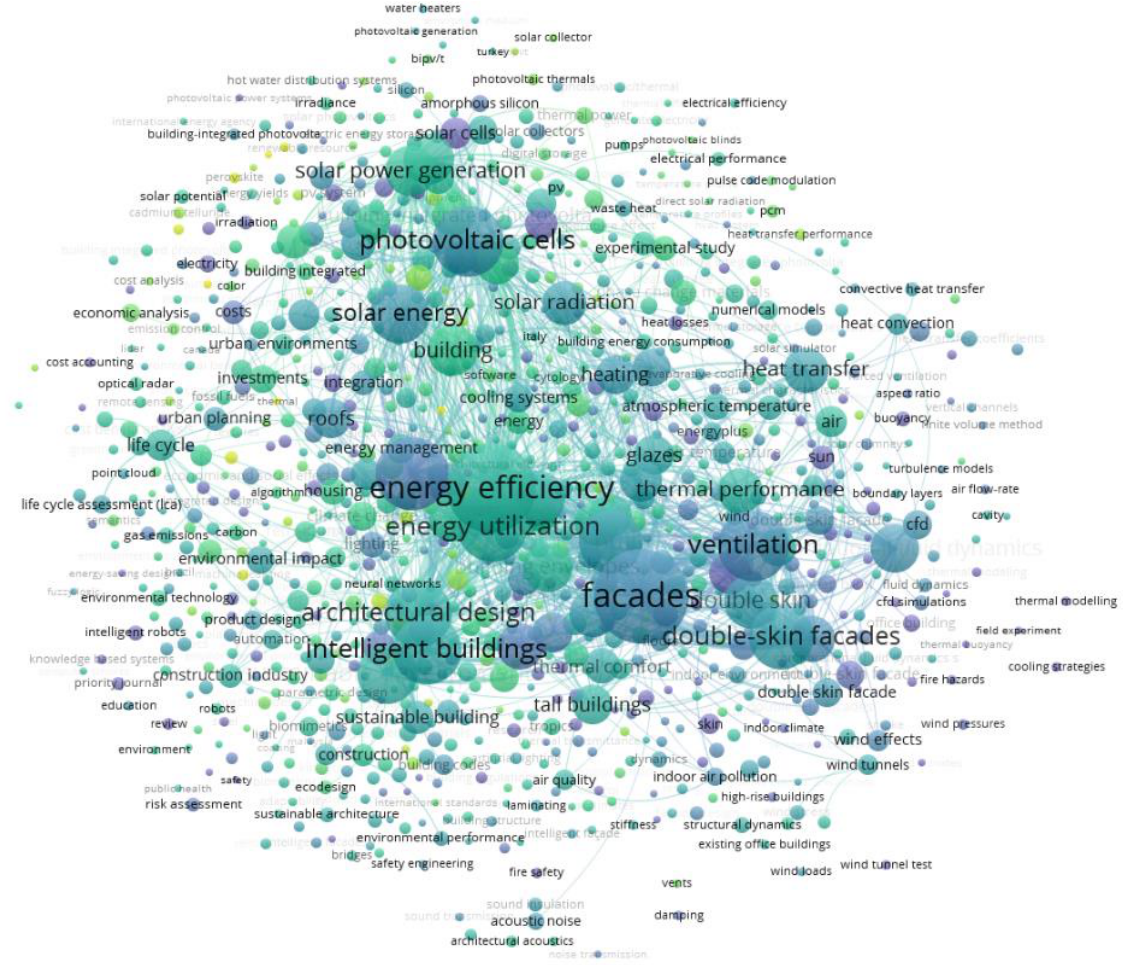
Figure 2. Visualization of scientific landscapes by indexed keywords, SCOPUS (VOS Viewer).